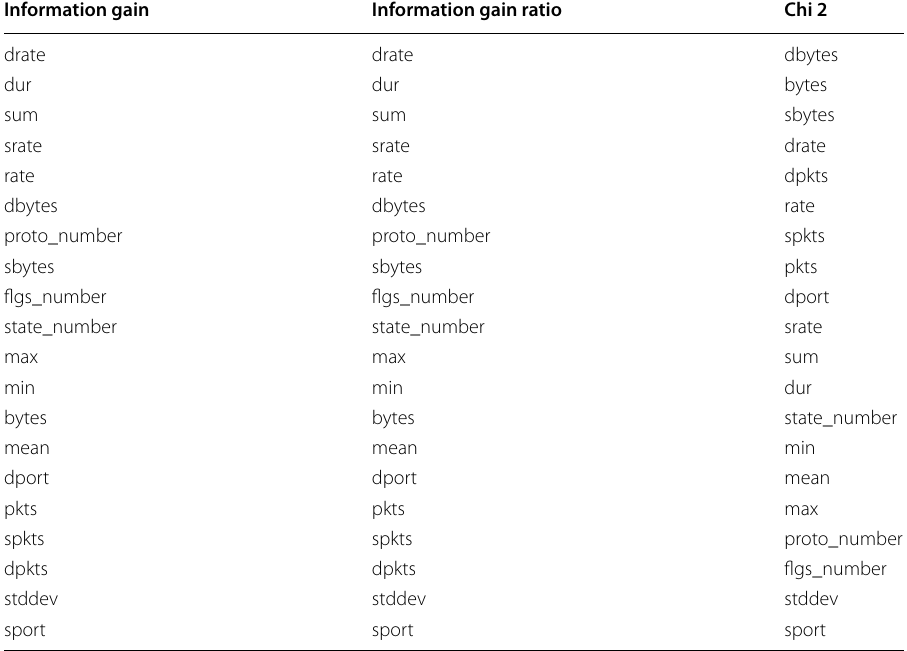
Table 52 Features by filter-based feature